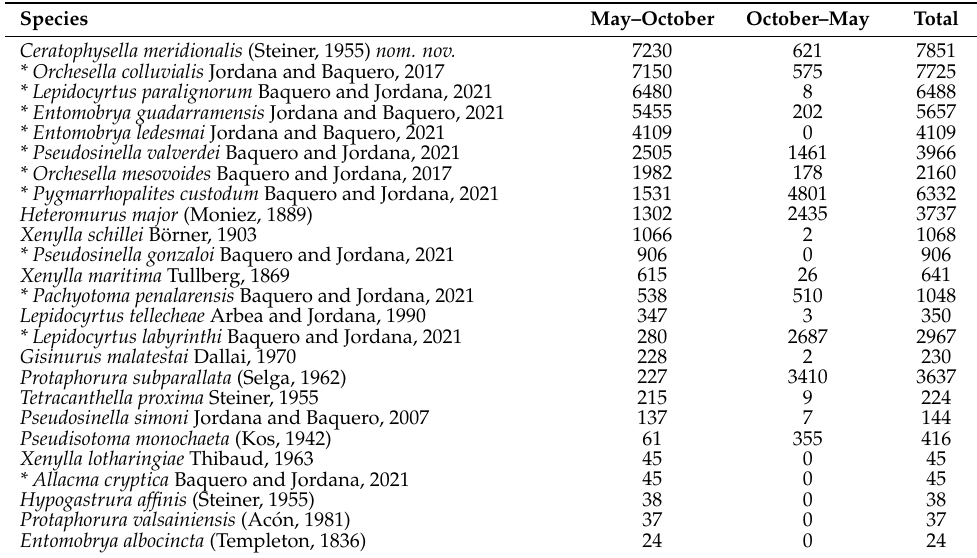
Table 2. Total list of species found in the sampling, in the two sessions, ordered by abundance for the first extraction from the traps. The numbers are the total number of specimens for each species. Species Ceratophysella meridionalis (Steiner, 1955) nom.